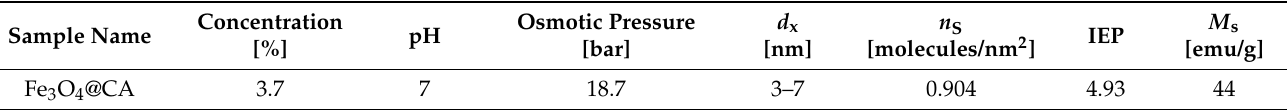
Table 3. Concentration, pH, osmotic pressure, size, surface ligand concentration, IEP, and magnetic saturation of Fe 3 O 4 @CA MNP’s.